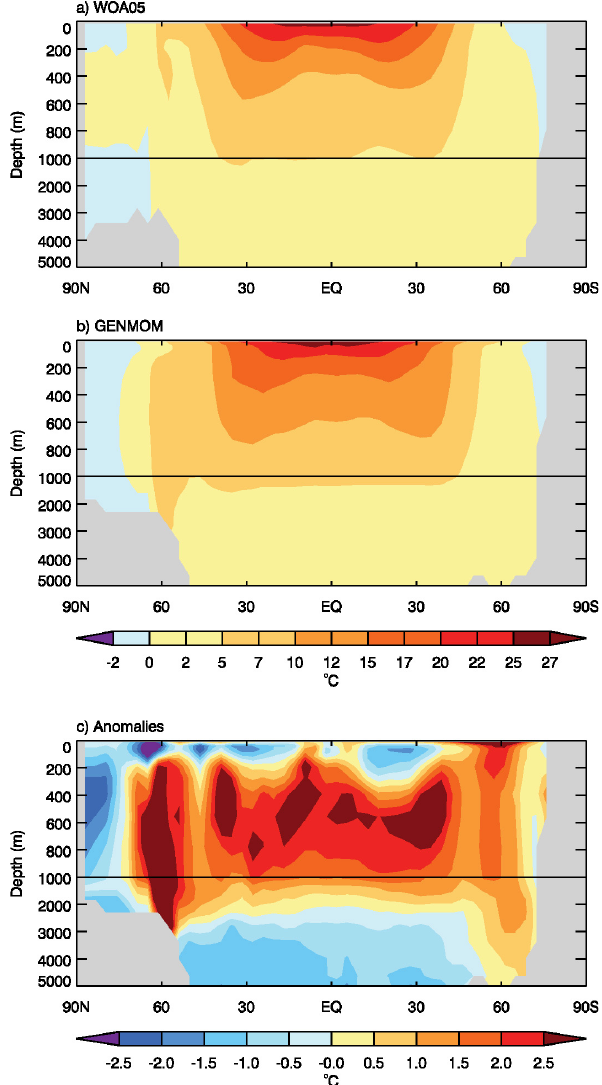
Fig. 7. Mean-annual zonally averaged ocean potential temperature profile. (a) Observed (WOA05), (b) GENMOM, (c) Anomalies, calculated as GENMOM –